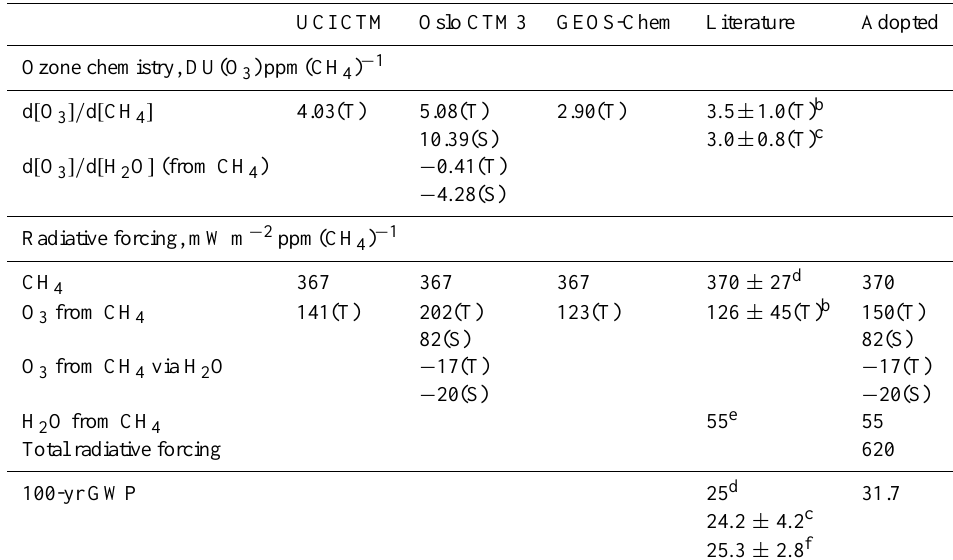
Table 5. Present-day, steady-state methane impact on ozone and radiative forcing a